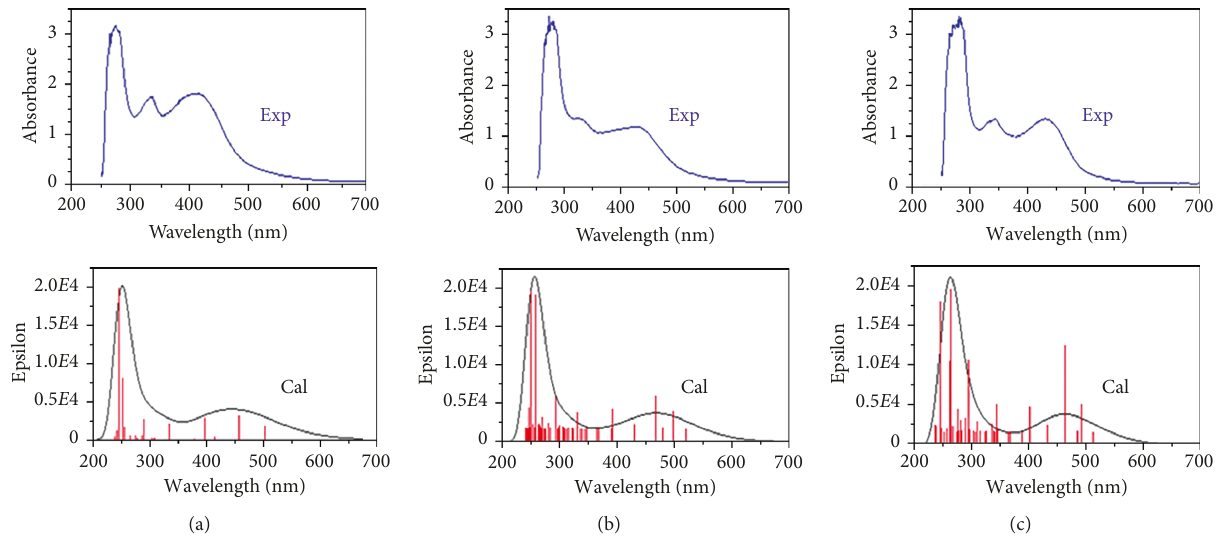
Figure 3: Recorded and calculated electronic absorption spectra of [RuCl